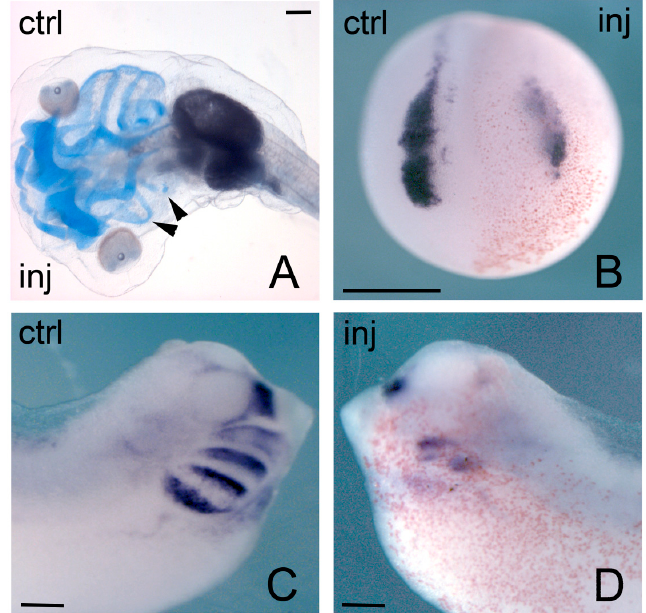
Figure 4. Phenotypic effects of Hmga2 depletion on Xenopus embryos. ( A ) Morpholino-injected stage 42 embryo show impairment of NCCs-derived skeletal elements on injected side as revealed by alcyan blue staining; ( B ) Neurula morphant embryo showing downregulation of snai2 expression on injected side; ( C , D ) A clear reduction of twist expression was observed in injected side of stage 28 tailbud embryos when compared to control side. Inj, injected side; ctrl, control side. Scale bar: ( A – D ) 400 μ m. Because part of the role of NCS genes, such as snai1/2 and twist , is to elicit the EMT in NCCs [142], among the consequences of Hmga2 depletion there is the impairment of EMT and NCC